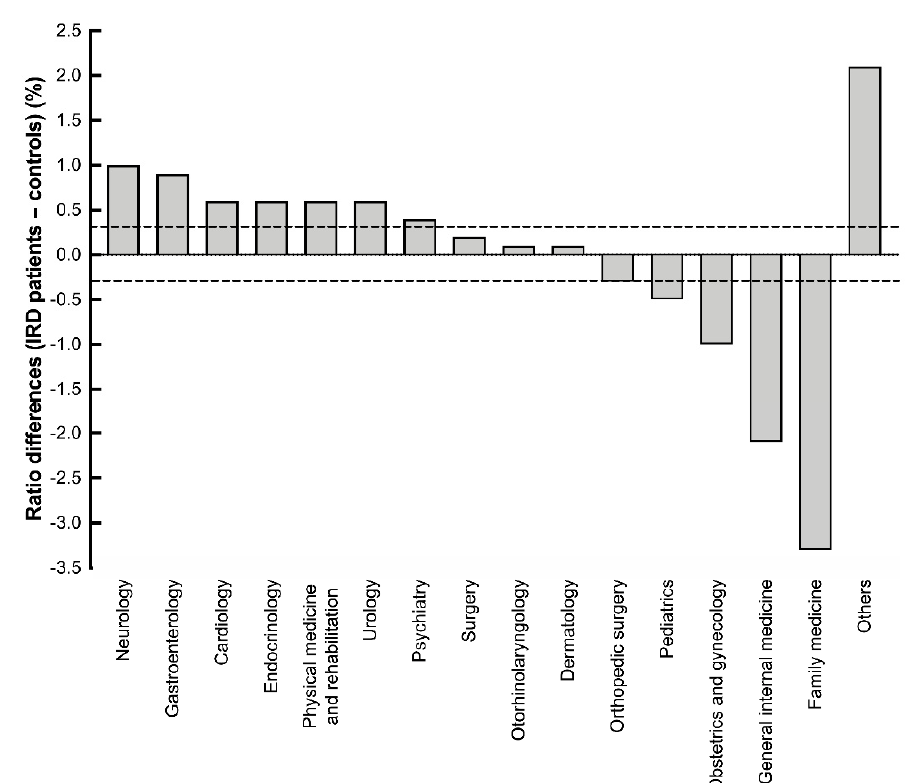
Figure 5. Rate differences in the specialty usage between patients with internal retinal degenera- tions and the general population. All aforementioned items significantly differed between the groups, with p < 0.001. However, we considered the significance to be “clinically meaningful” at a difference of at least